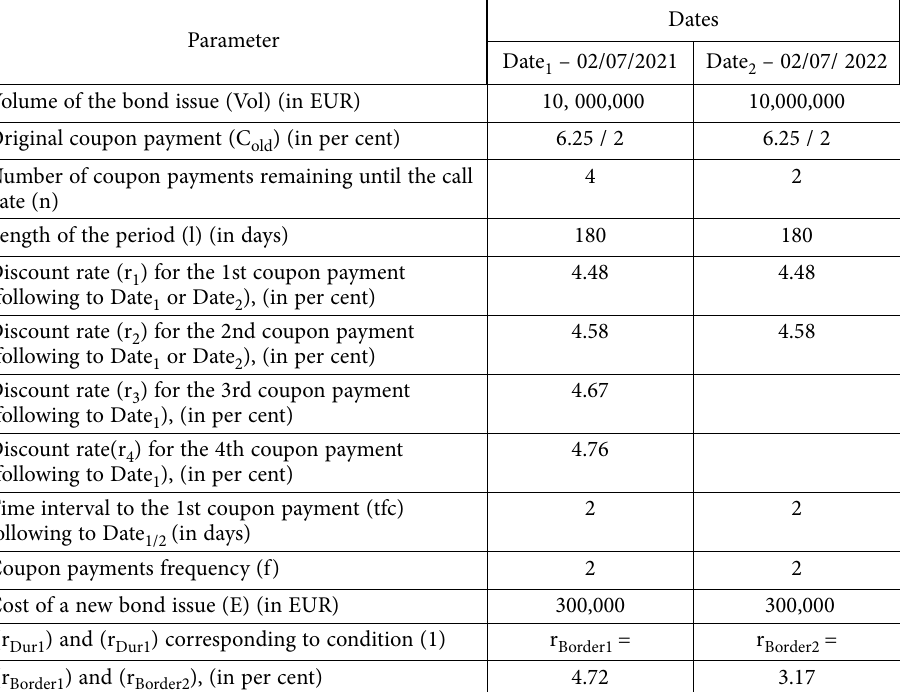
Table 3. Calculation of border interest rates ((r Border1 ) and (r Border2 )) that are congruent with the condi- tion to call the bond issue at (Date 1 ) and (Date 2 )